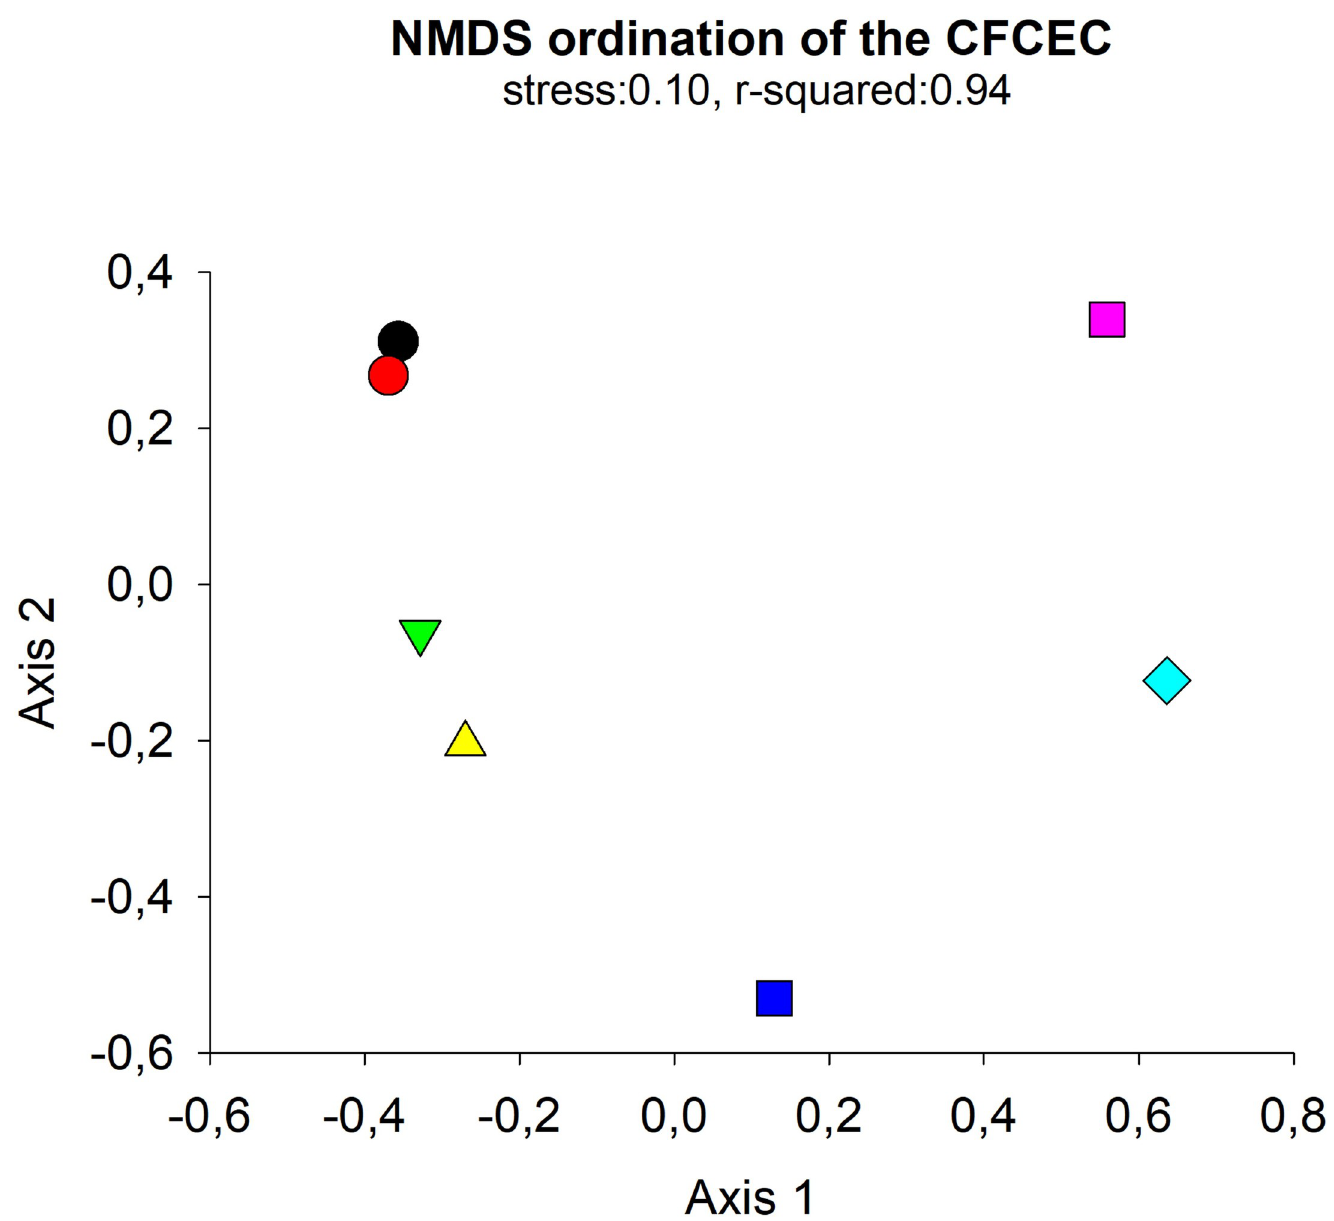
Fig 6. NMDS ordination derived from a thetaYC distance matrix of the bacterial 16S rRNA gene amplicon Illumina sequencing. Each point corresponds to the microbial community of the days 0, 1, 2, 3, 5, 17 and 33 of the CFCEC.